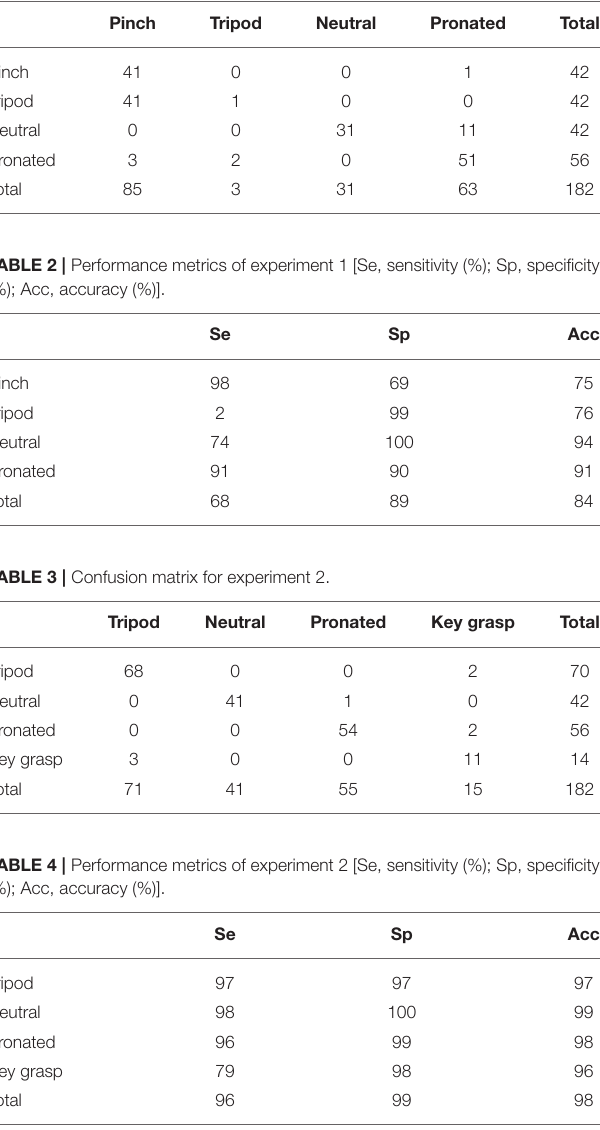
TABLE 1 | Confusion matrix for experiment 1.